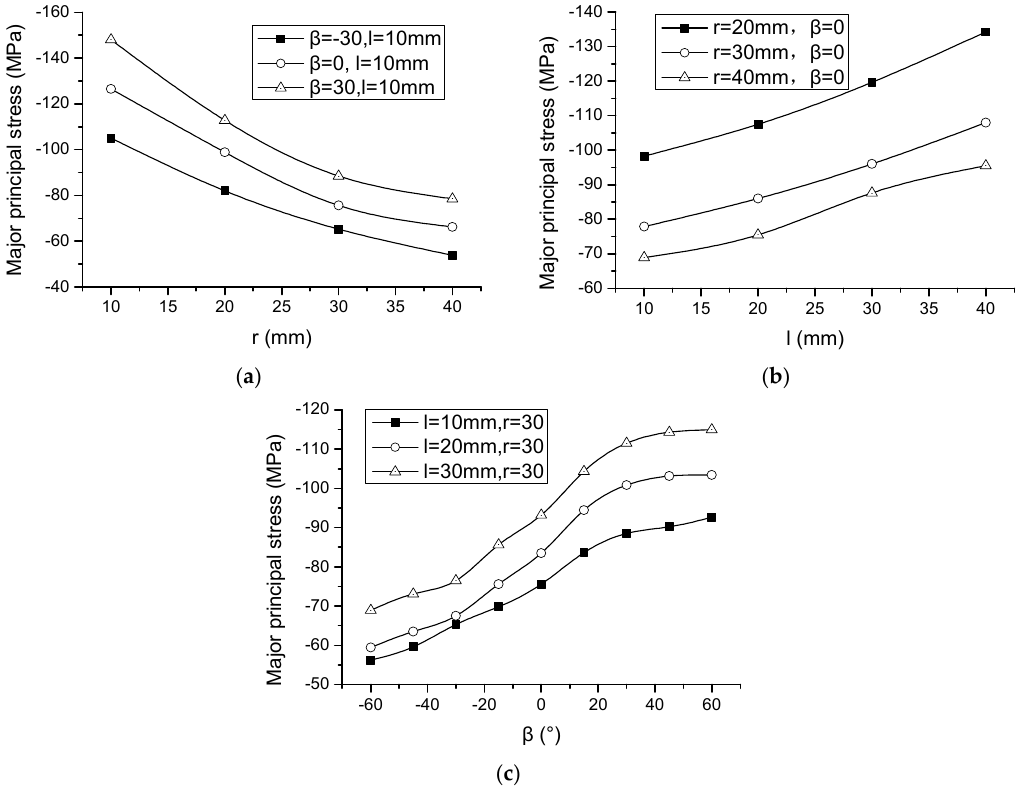
Figure 11. The effect of the geometrical parameters of diaphragm cutouts on the major principal stress: ( a ) the influence of arc radius ( l = 10 mm), ( b ) the influence of the length of the straight line ( β = 0°), ( c ) the influence of inclined angle ( r = 30 mm).